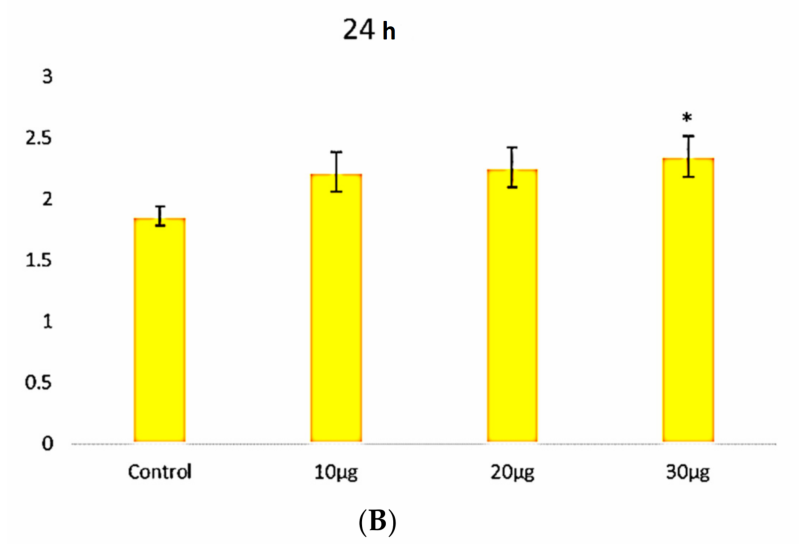
Figure 1. Proliferation effect of acetyl-xylogalactan on THK macrophages. ( A ) THK cells treated with acetyl-xylogalactan for 12 h; ( B ) THK cells treated with acetyl-xylogalactan for 24 h. * p < 0.05; ** p < 0.01. All treatment groups were compared to the control group.